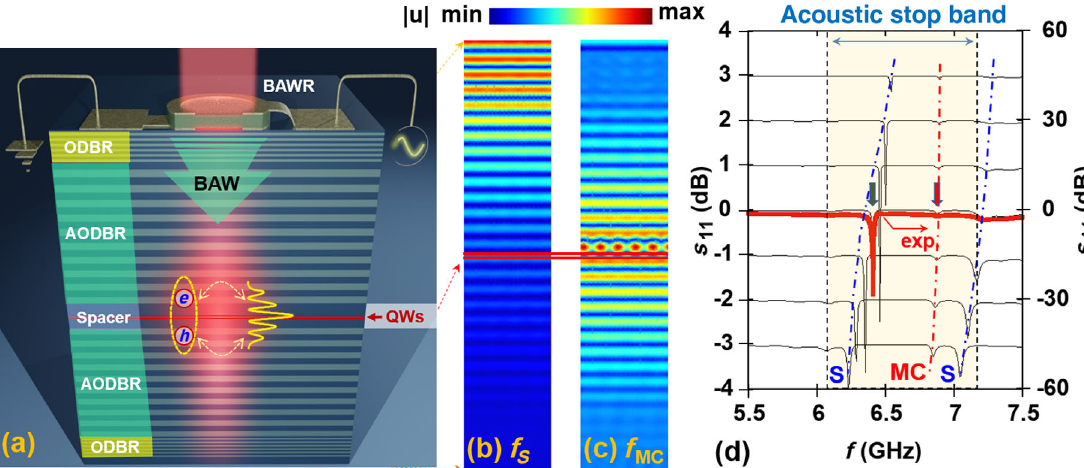
FIG. 1. Hybrid MC for polaritons and phonons. (a) Schematic cross section of sample A showing the spatial distribution of photon (red-shaded region) and exciton-polariton fields (yellow). ODBR and AODBR stand for the distributed Bragg reflectors (DBRs) acting as optical and acoustic mirrors, respectively. Longitudinal bulk acoustic waves (BAWs) are generated by a ring-shaped bulk acoustic wave resonator (BAWR) driven by rf voltage. The ring-shaped BAWR has an aperture for laser excitation of the MC. (b),(c) Profiles for ¼ 6 . 36 GHz) and (c) within the acoustic displacement field j u j calculated for the mode localized (b) at the sample surface (mode with f S ¼ 6 . 83 GHz; cf. thick arrows in (d)]. (d) Measured s the MC spacer [ f 11 rf-scattering parameter of the BAWR (thick red curve) and MC calculated s 11 profiles for different thicknesses d of the piezoelectric ZnO layer of the BAWR varying from 300 nm (bottom curve) to ZnO 180 nm (top curve) in steps of 20 nm (thin black lines). The calculations are done according to the procedure outlined in Ref. [43]. The colored area in (d) indicates the spectral extent of the acoustic stop band of the